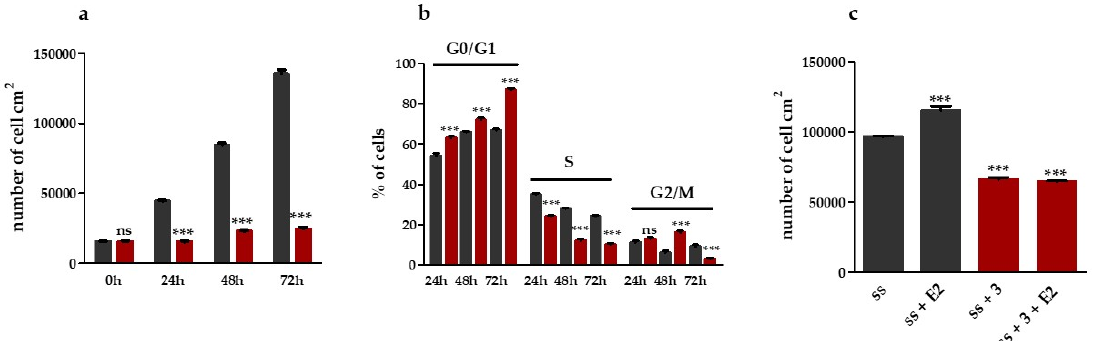
Figure 2. Compound 3 inhibits IGROV1 cells growth: ( a ) IGROV1 cells viability after treatment with 3 (red) is compared with untreated cells (gray); ( b ) IGROV1 cells were treated with compound 3 (red) and the isolated nuclei stained with PI were analyzed by flow cytometry; and ( c ) E2 induces proliferation in serum starved (ss) but not in compound 3 treated IGROV1. Cells were serum starved or treated with 5 µ M compound 3 for 24 h. Each group was then stimulated with 1 nM E2 and cell growth measured. Statistical analysis was carried out using Prism GraphPad *** p < 0.001. n.s., not